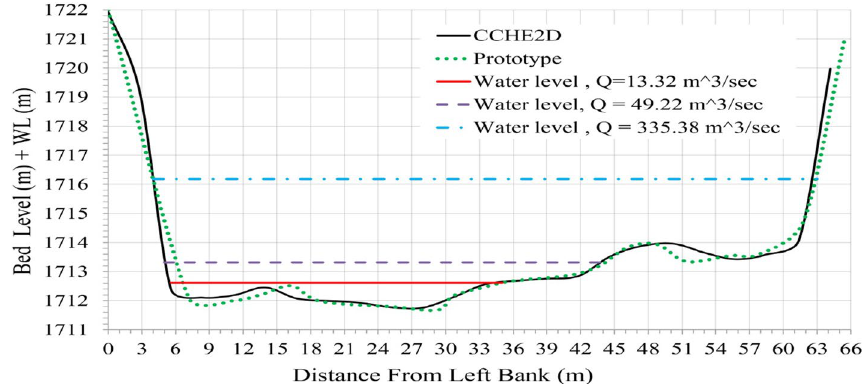
Fig. 3 Cross section profile at Shahmokhtar hydrometric